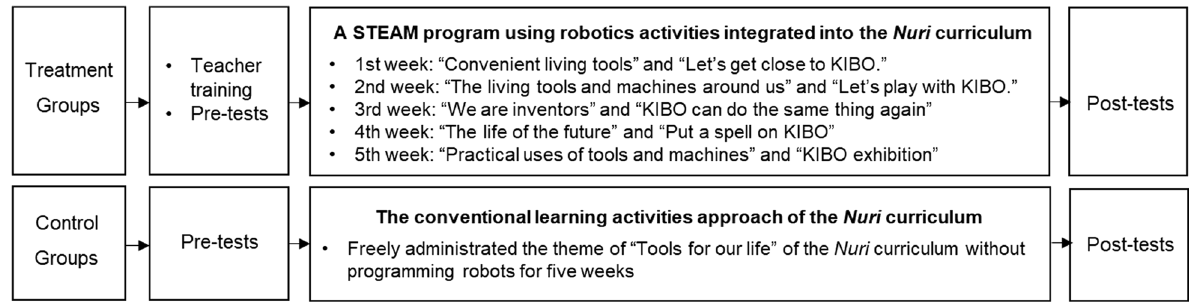
Fig. 2 Research procedures of treatment group and control